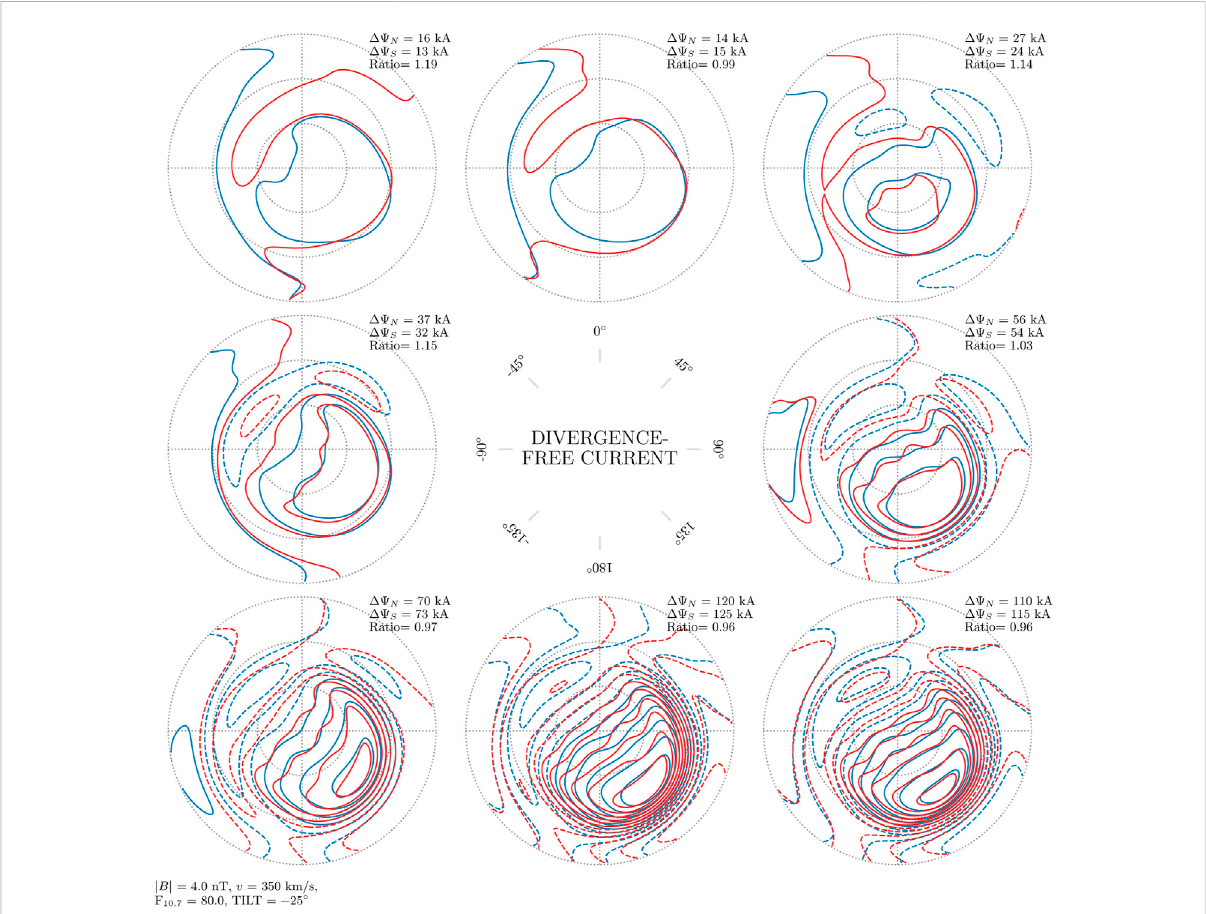
FIGURE 6 Divergence-free current function in the Northern and Southern Hemisphere (blue and red contours, respectively), as a function of IMF clock angle for dipole tilt angle ψ = − 25 ° , where the signs of B y and ψ are reversed for the Southern Hemisphere. The spacing between contours is 10 kA. In this fi